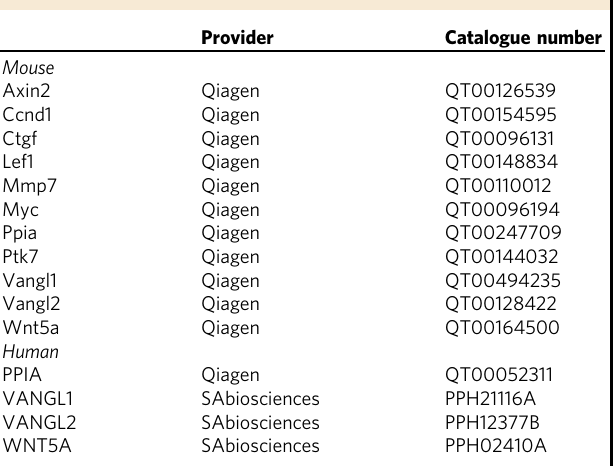
Table 1 qPCR primers used in this